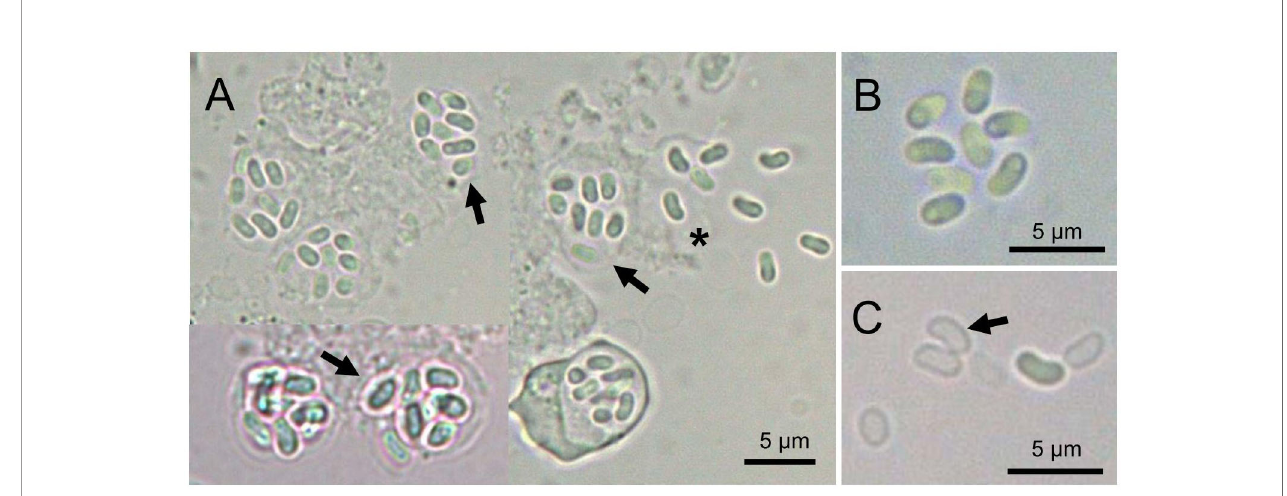
FIGURE 1 | Light microscopy of Nucleospora hippocampi n. sp. (A) The infected enterocytes contain eight spores (arrows). Eight spores are released from the ruptured enterocyte (asterisk). (B) Higher magni fi cation of eight fresh spores. (C) The arrow shows the empty spore